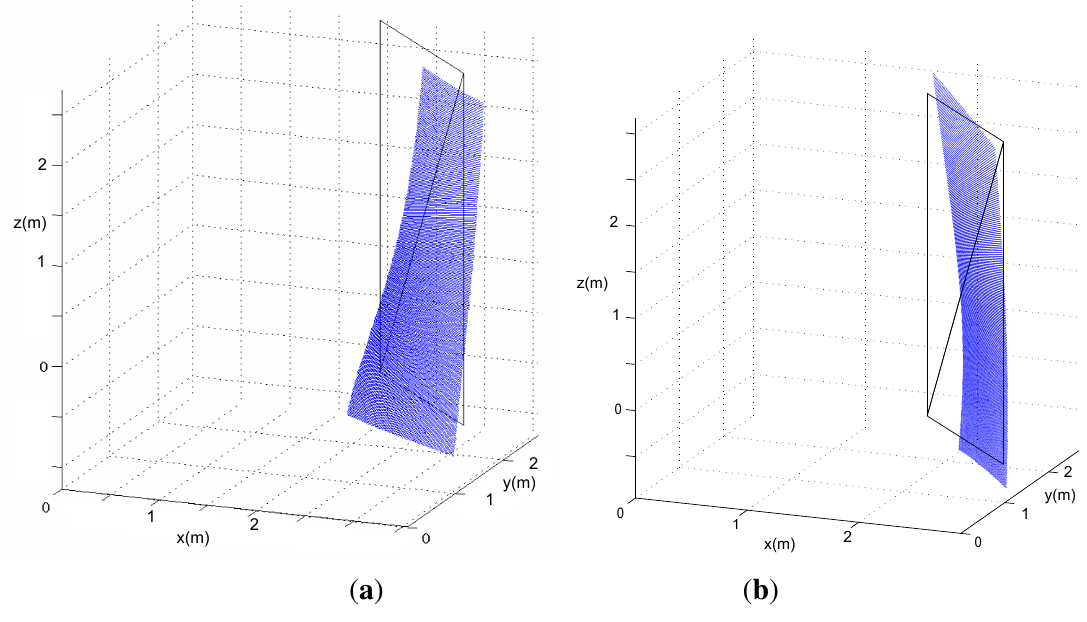
Figure 4. Simulated 3D scan of a planar surface scanned from a 3D device with ( a ) α = 10 ◦ . Null coordinates correspond to the origin of the optical frame of the and ( b ) γ 0 3D